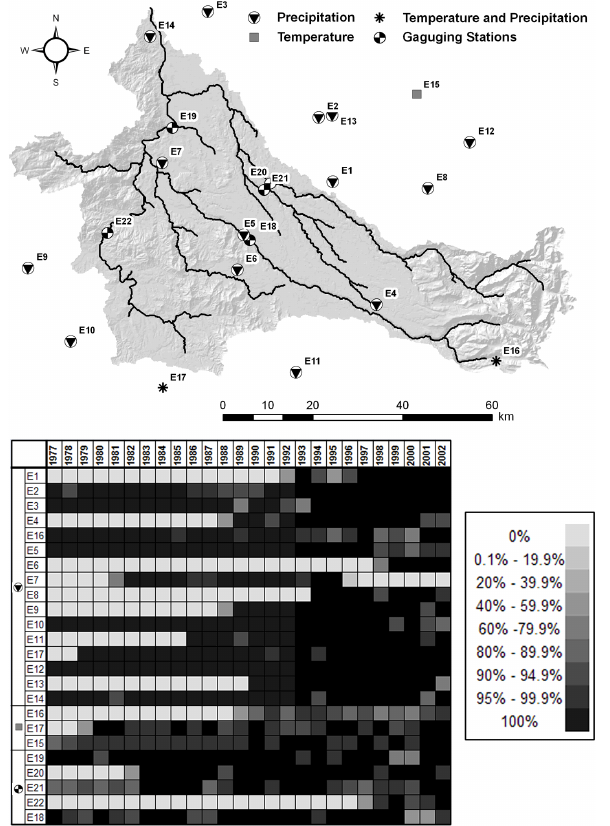
Fig. 4. Location of hydrometeorologic stations and available record periods.